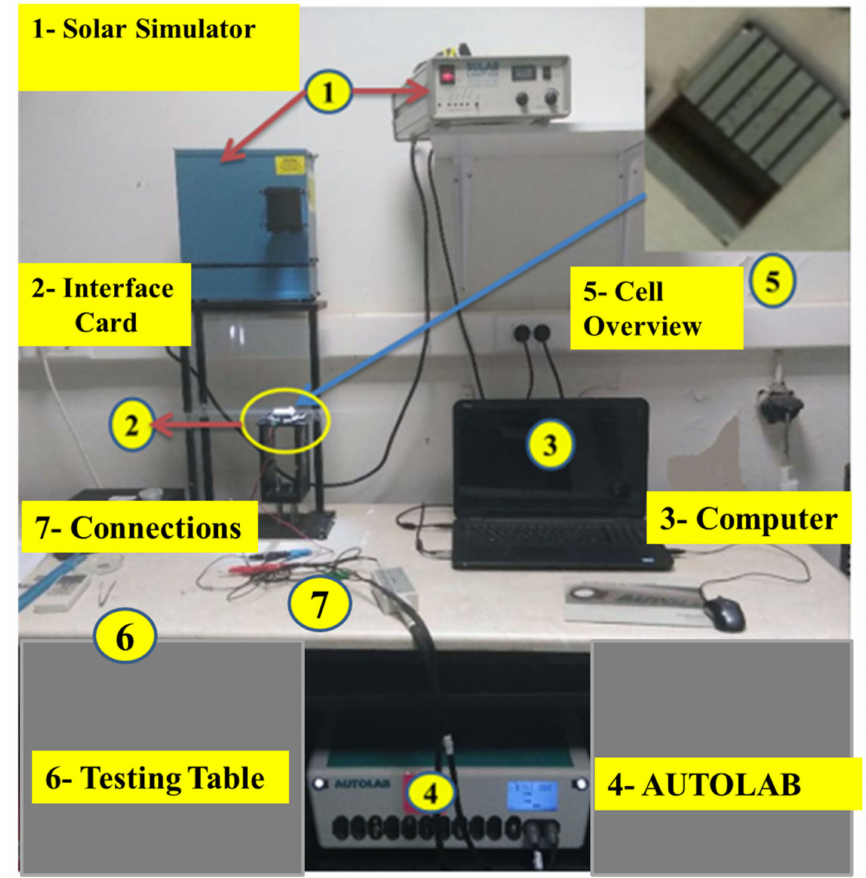
Figure 4. The perovskite solar cell J-V curves measuring